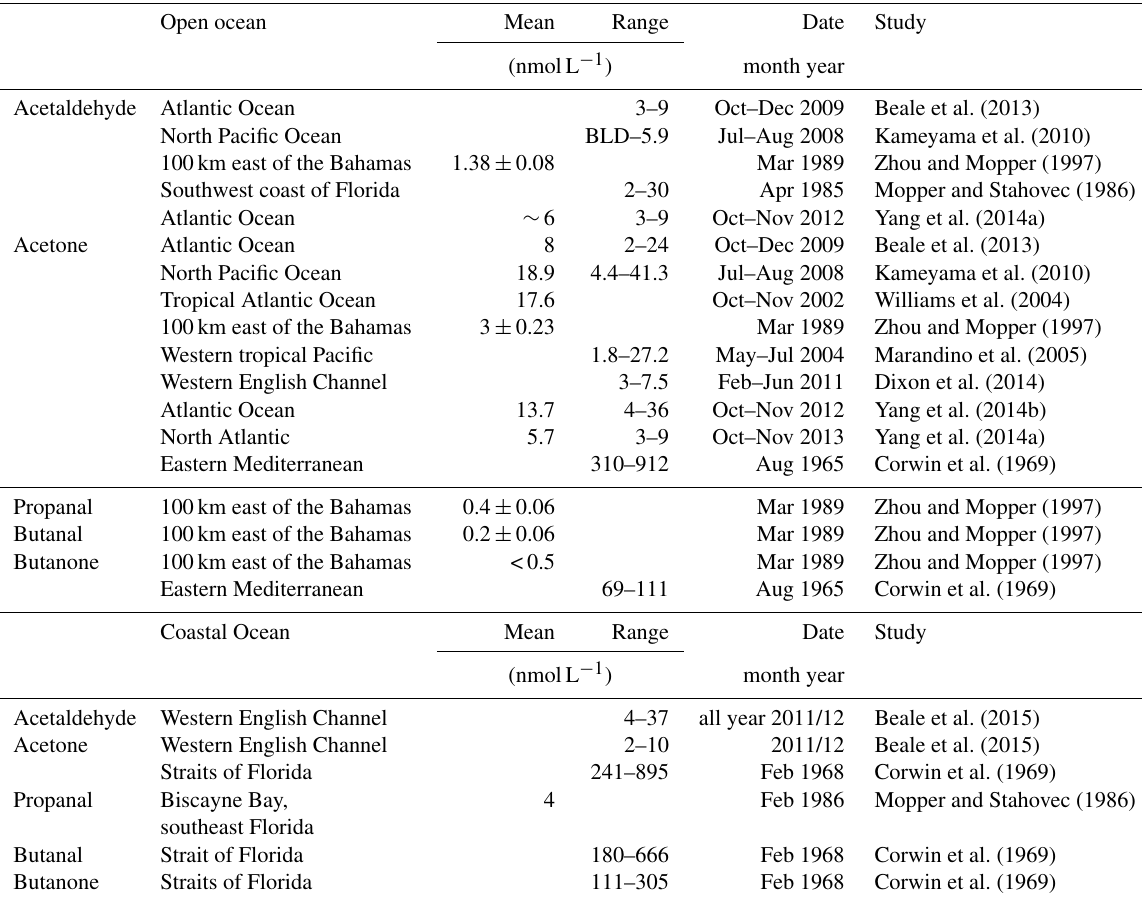
Table 2. Literature values of OVOCs in the open and coastal oceans. BLD: below limit of